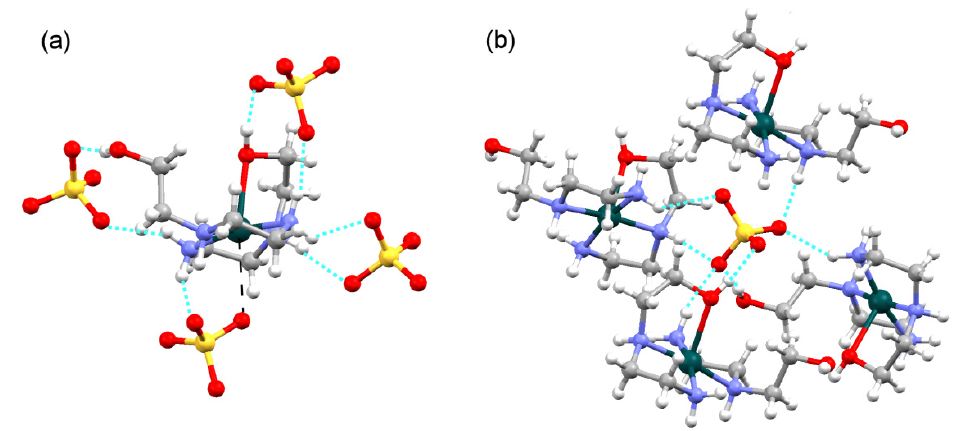
Figure 2. H-bonding cation-anion recognition in the crystal of compound 1 . H-bonds depicted as dotted cyan lines. ( a ) Complex cation surrounded by four sulfate anions. The Cu-O(sulfate) contact (2.879(3) Å) is depicted as dashed black; ( b ) Sulfate anion surrounded by four complex cations. Atoms colour code: carbon—grey; hydrogen—white; nitrogen—blue; oxygen—red; copper—dark green; sulfur—yellow.